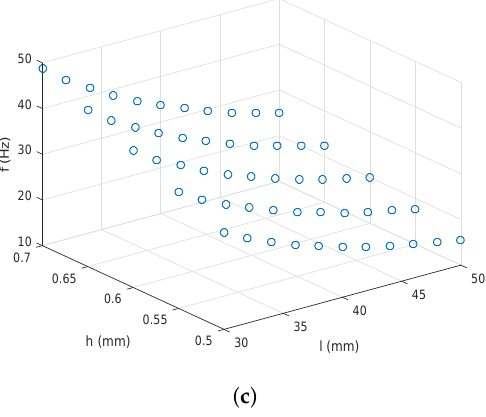
Figure 6. The relationships of thickness and length of the leaf flexure with ( a ) total deformation, ( b ) safty factor, and ( c ) resonant frequency.